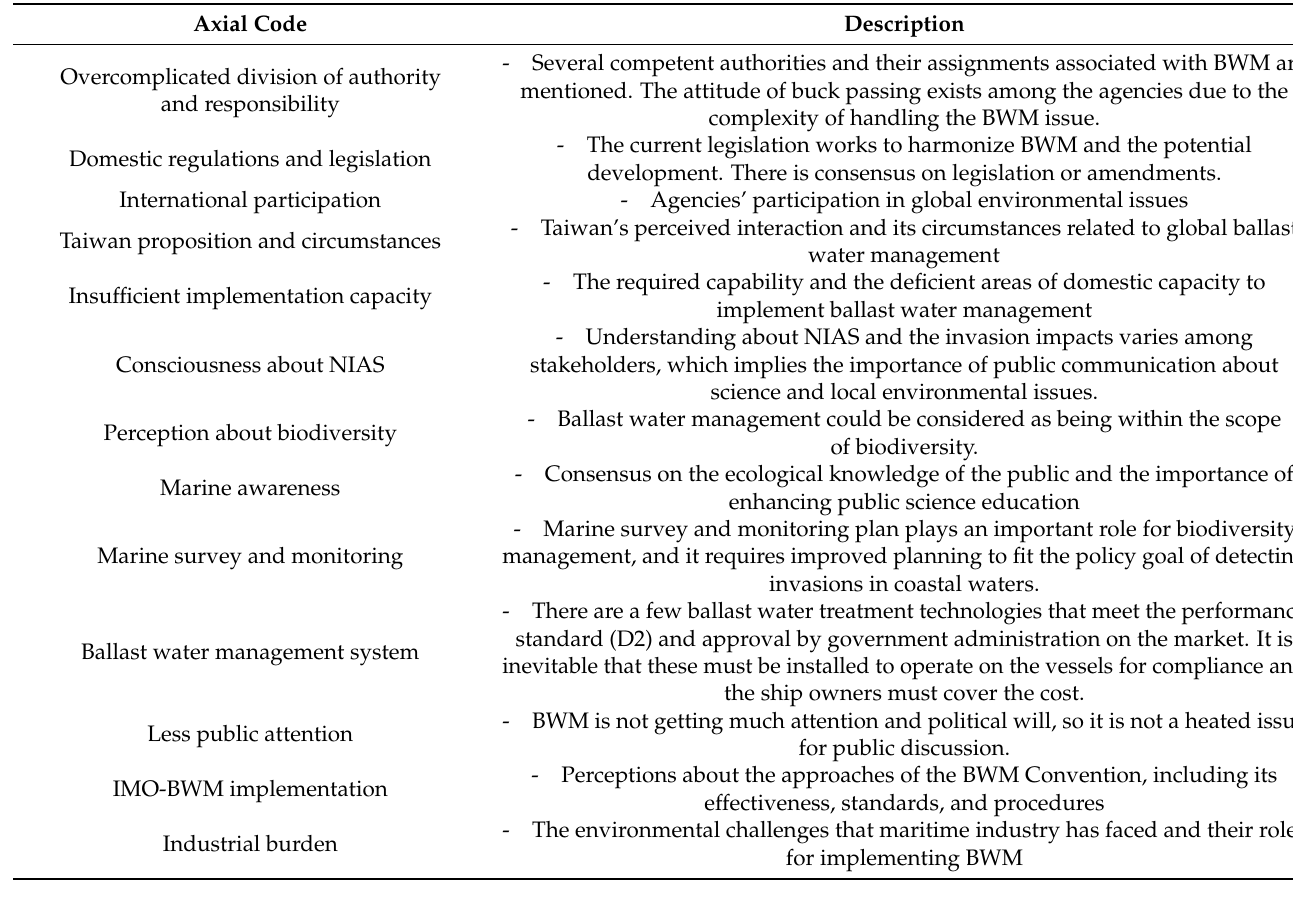
Table 3. The axial codes and their